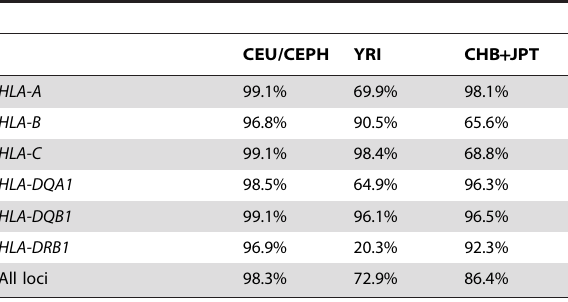
Table 3. Imputation accuracy of classical alleles at 4-digit resolution across worldwide populations.